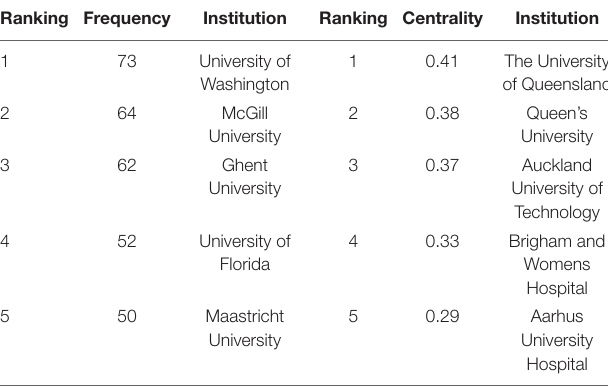
Frontiers in Psychology |